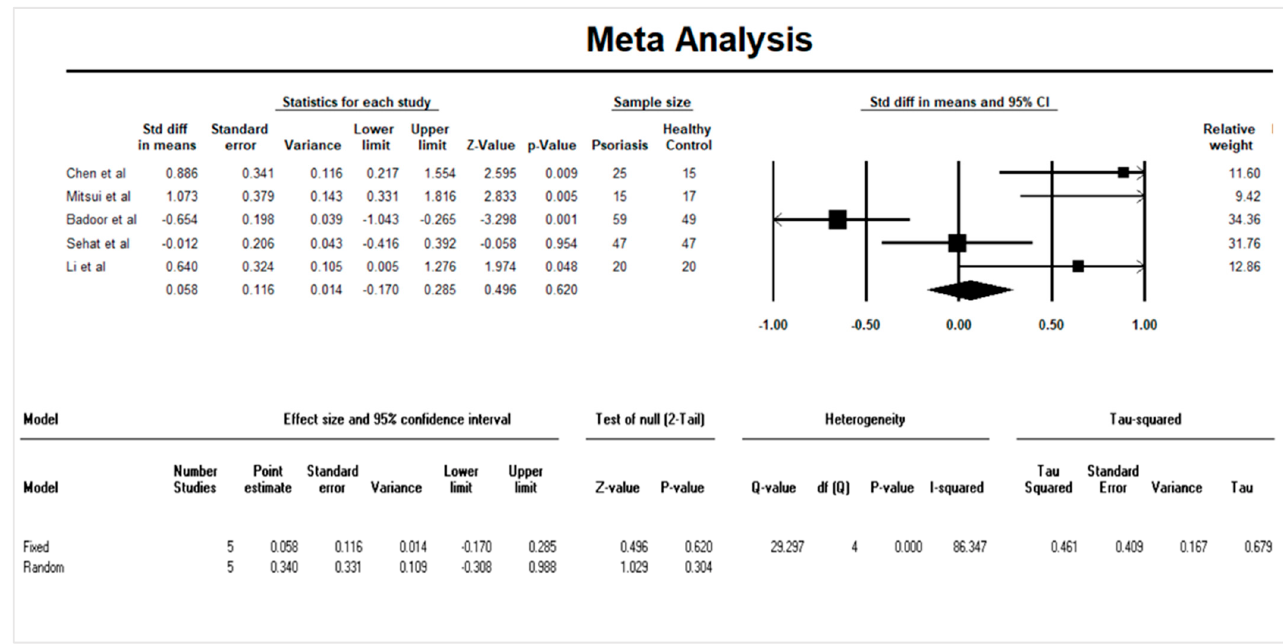
Figure 2. Forest plot of serum IL-33 and Psoriasis